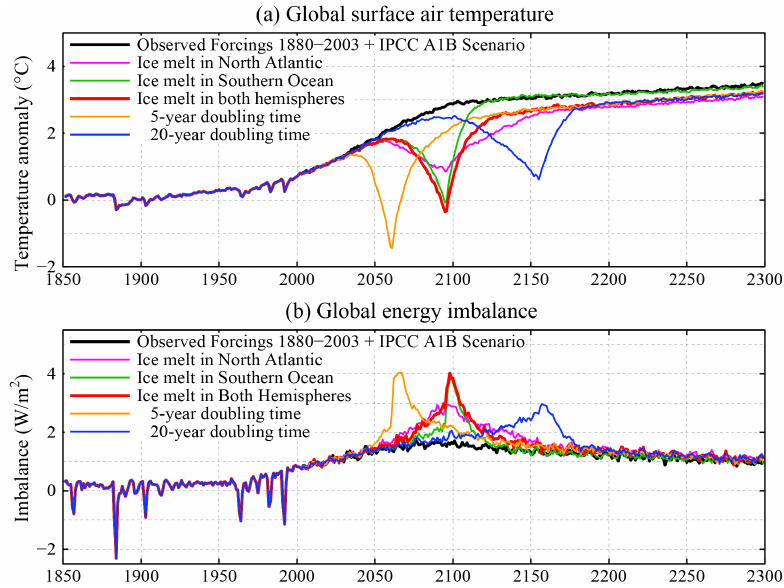
Figure 7. (a) Surface air temperature ( ◦ C) relative to 1880–1920 for several scenarios. (b) Global energy imbalance (Wm − 2 ) for the same